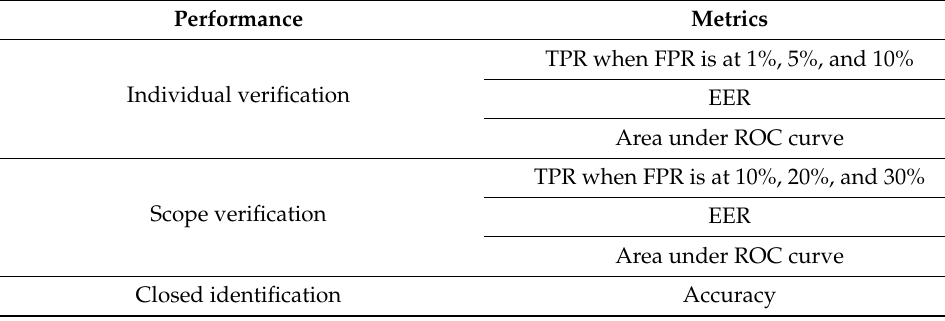
Table 9. Metrics used to evaluate the model performance.